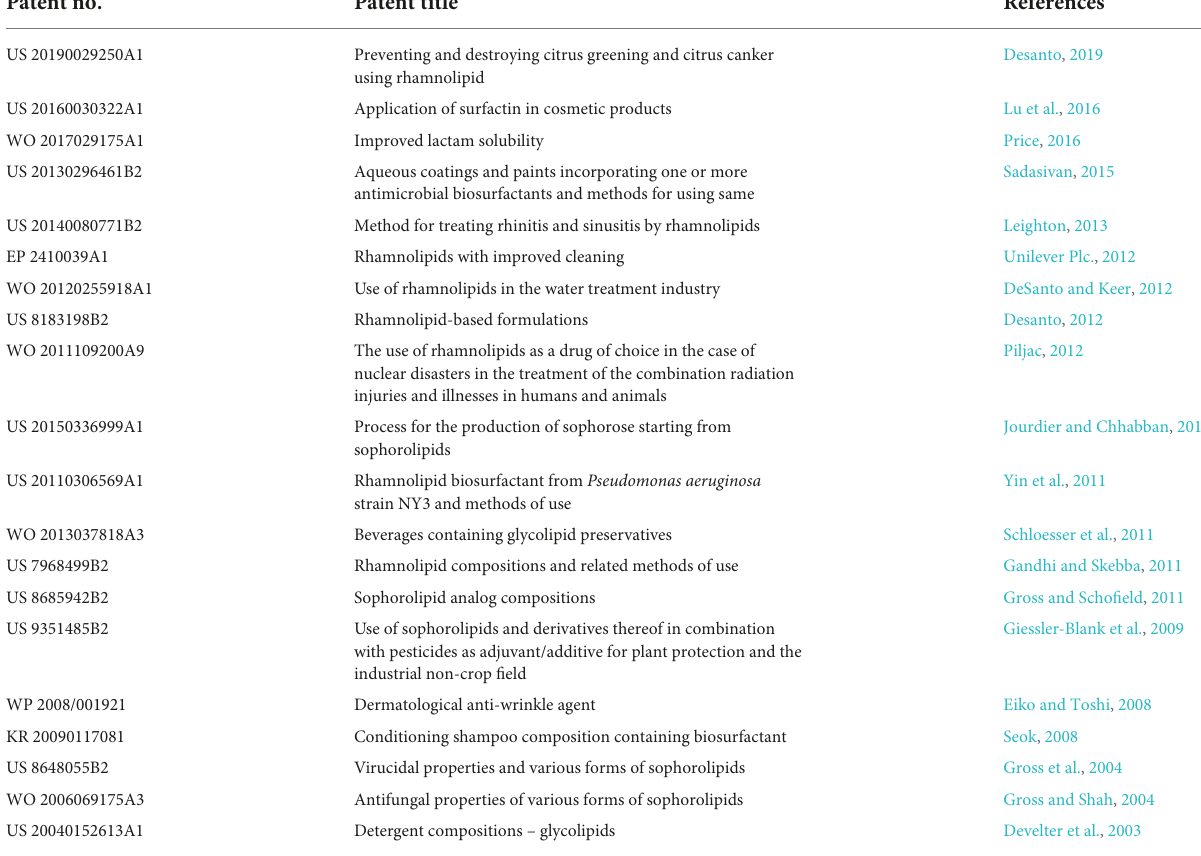
TABLE 4 Patents of biosurfactant production and applications. Patent